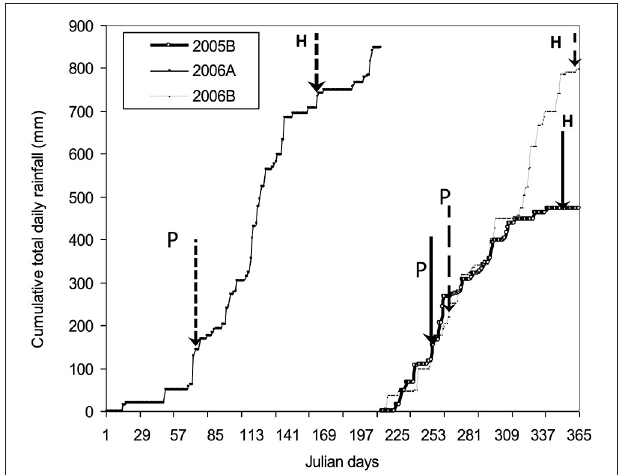
FIGURE 1 | Cumulative daily rainfall received in the study area during field experimentation for three subsequent seasons 2005B, 2006A, and 2006B. P and H denote planting and harvesting,